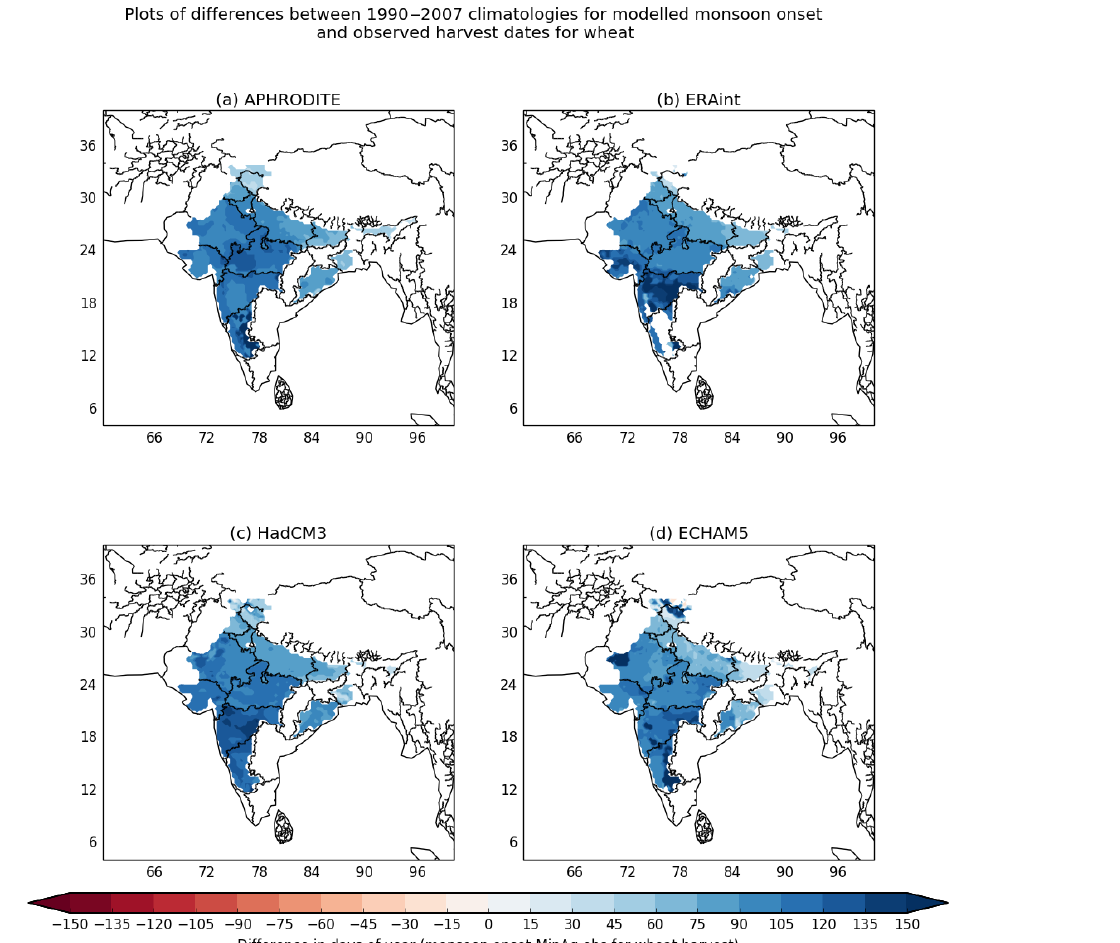
Figure B3. The difference between the midpoint of the monsoon onset in the model and the midpoint of the observed wheat harvest period for